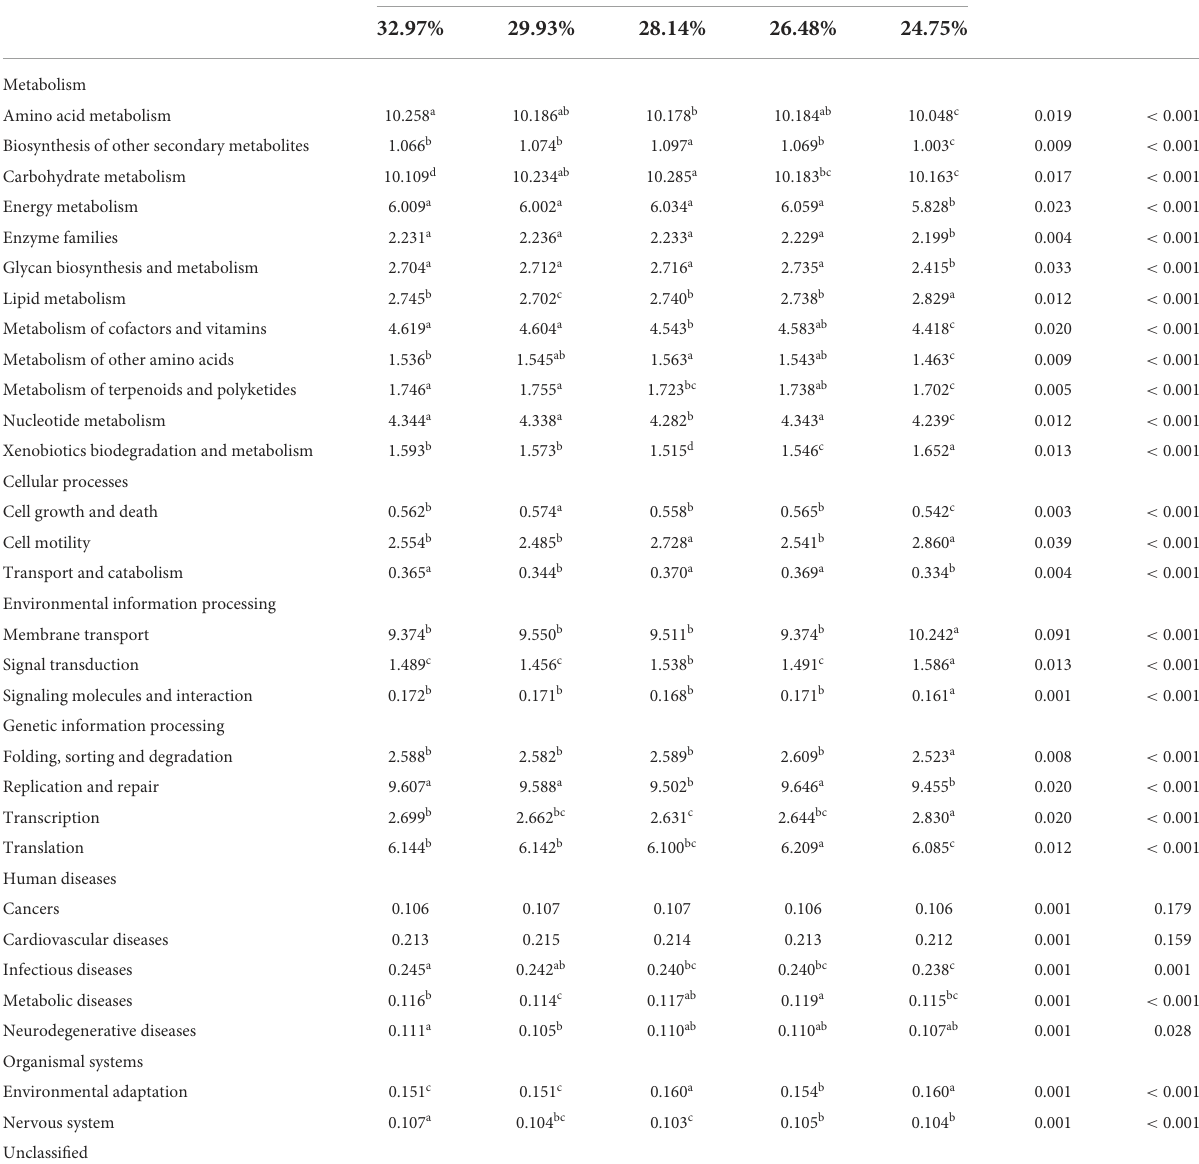
TABLE 9 Effects of dietary peNDF > 1.18 level on the functional prediction of rumen archaea (%).